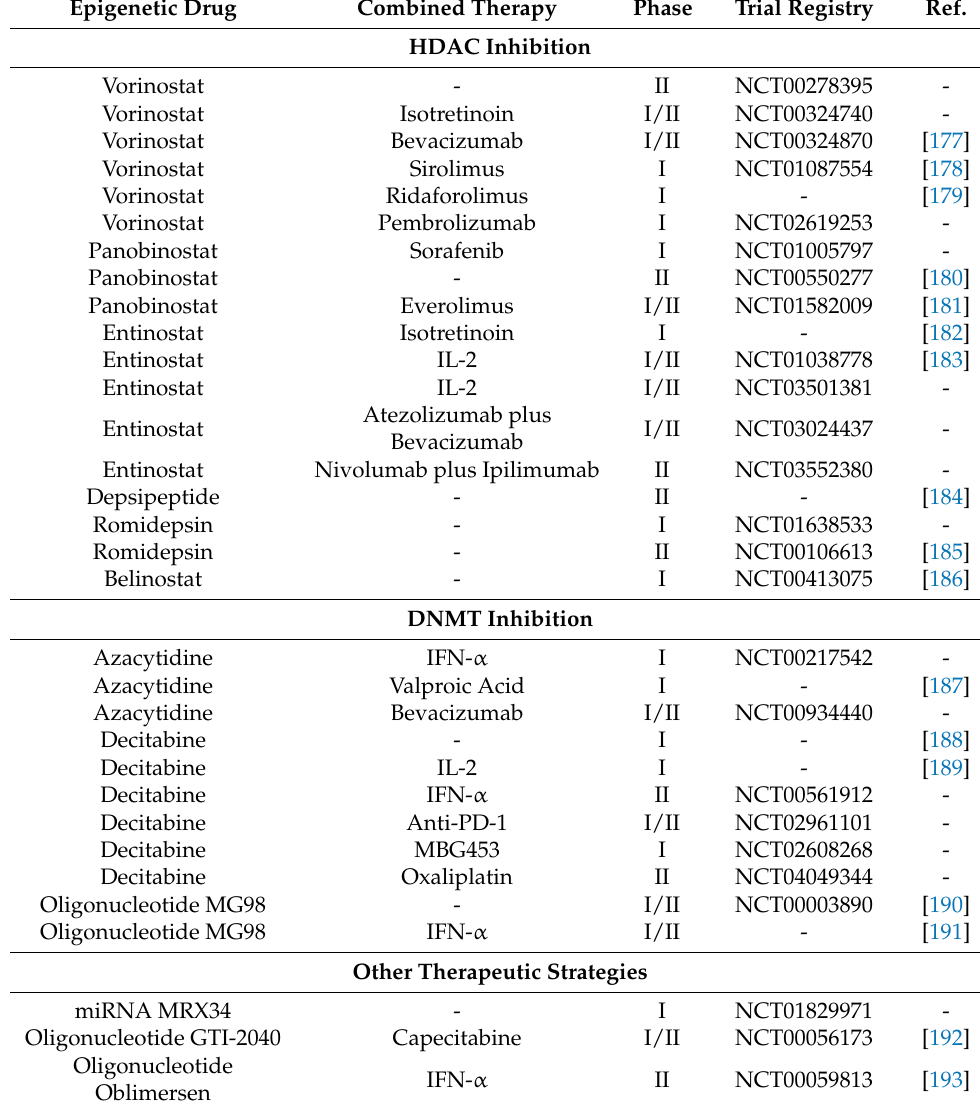
Table 1. Epigenetic treatments alone or in combination with other treatments used in clinical trials conducted on patients with metastatic or unresectable renal cell carcinoma, or in advanced solid tumors including renal cell carcinoma (clinicaltrials.gov, accessed on 1 March 2021). HDAC: Histone deacetylase; DNMT: DNA methyltransferase. Ref.: reference number as cited in the